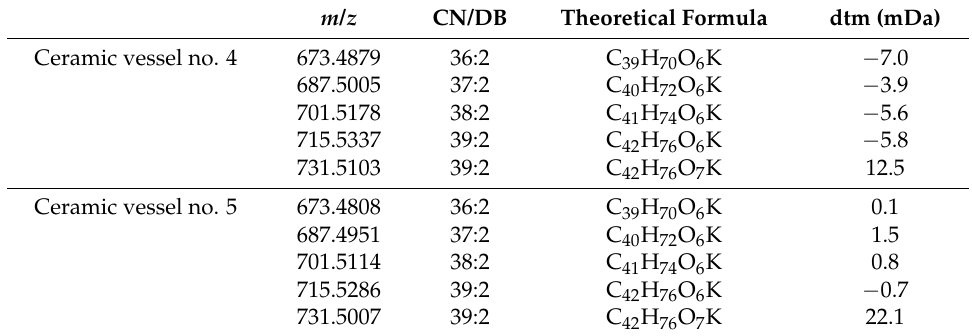
Table 1. List of the most significant markers of the bottom soil layers taken from the two studied vessels. m / z CN/DB Theoretical Formula dtm (mDa) Ceramic vessel no. 4 673.4879